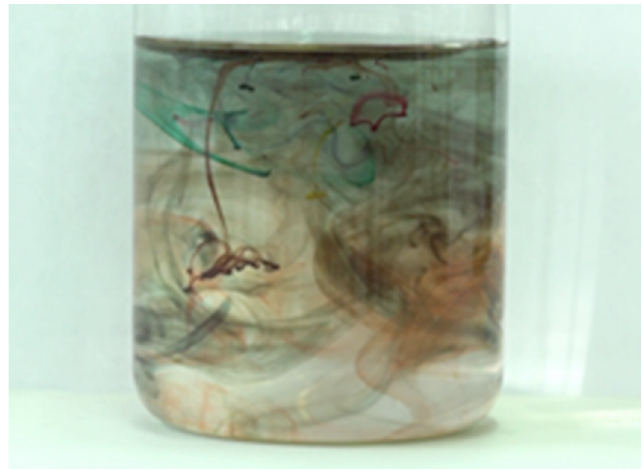
Figure 7. Small drops of colour touch the water